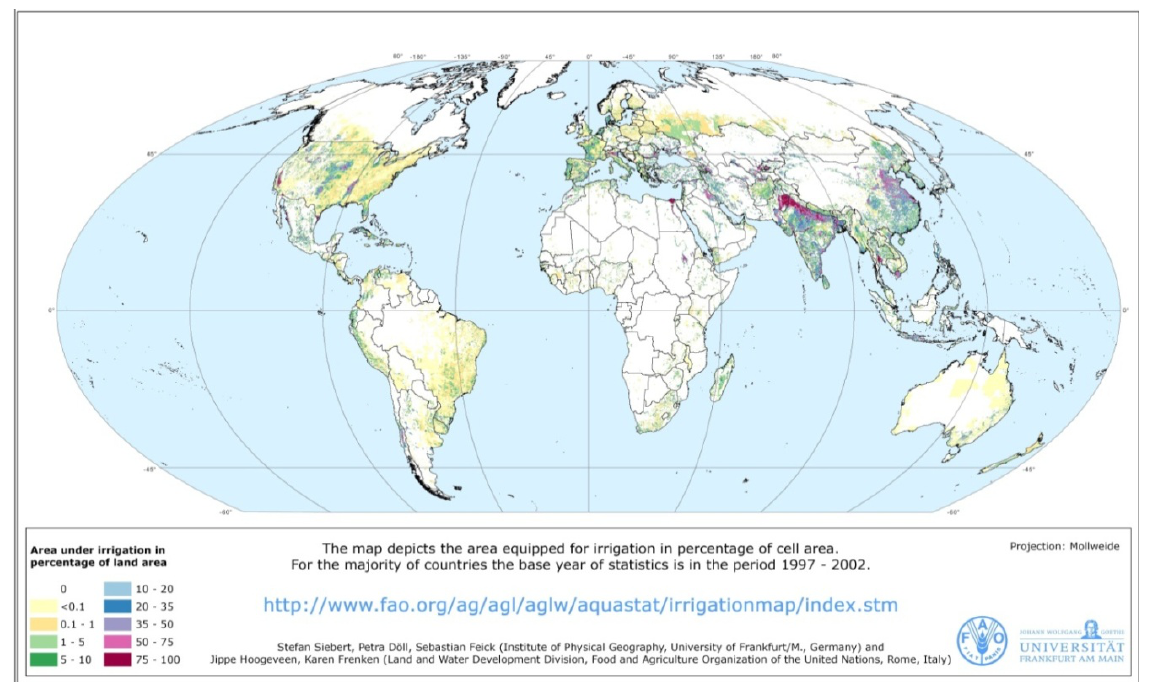
Figure 4. Global irrigated cropland area map [52]. This includes only areas “equipped” for irrigation in the world. Total area of irrigated croplands is 278 Mha. The product is derived using the national agricultural census data and GIS. The output is given in nominal 5-min (0.083333 decimal degrees)